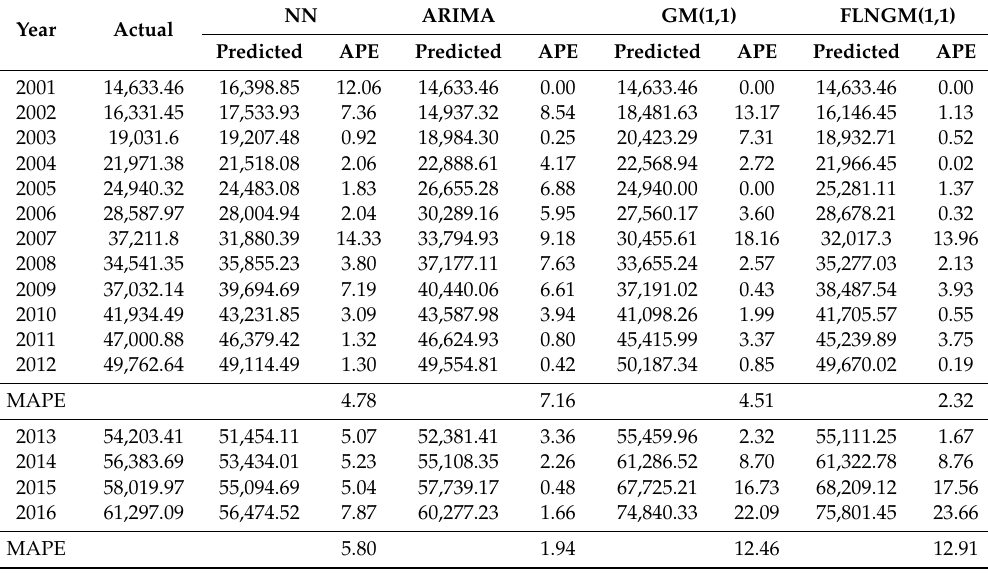
Table 2. Forecasting accuracy of di ff erent prediction models for Case I (unit: 100 million